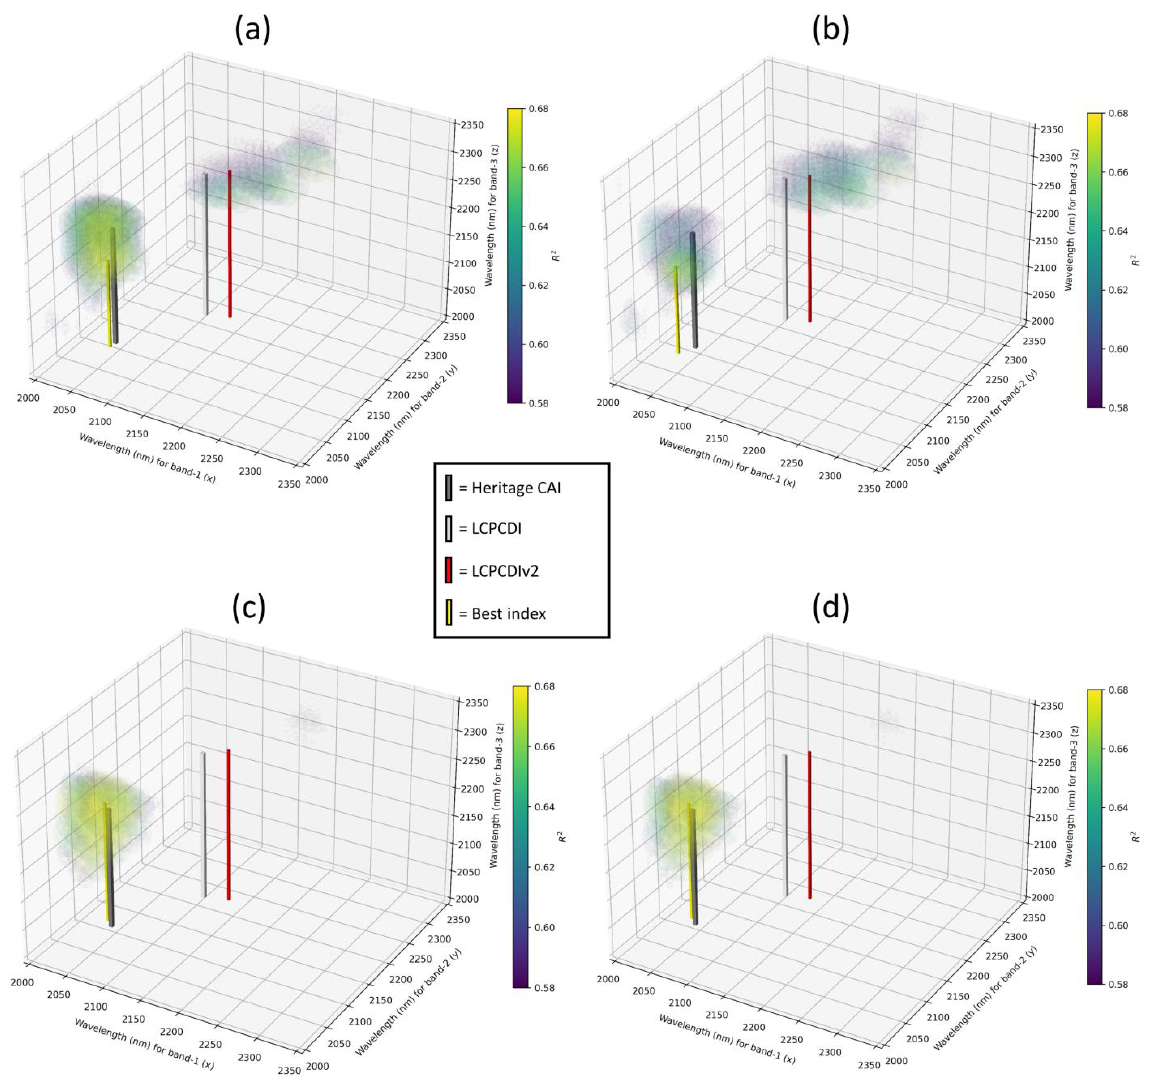
Figure 7. Three-band wavelength shift analysis f R estimation results with the 10 nm full-NDVI da- taset. ( a ) gCPDI (full-NDVI) surface reflectance, ( b ) gCPDI (full-NDVI) with atmospheric artifacts, ( c ) gCPRI (full-NDVI) surface reflectance, ( d ) gCPRI (full-NDVI) with atmospheric artifacts. Note